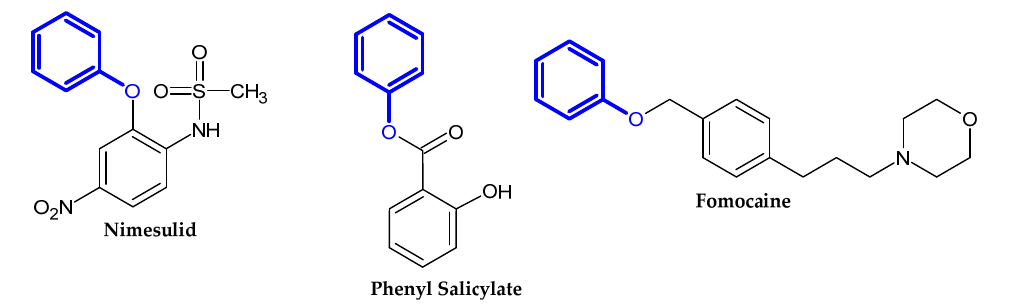
Figure 5. Analgesic drugs currently used in treatment.